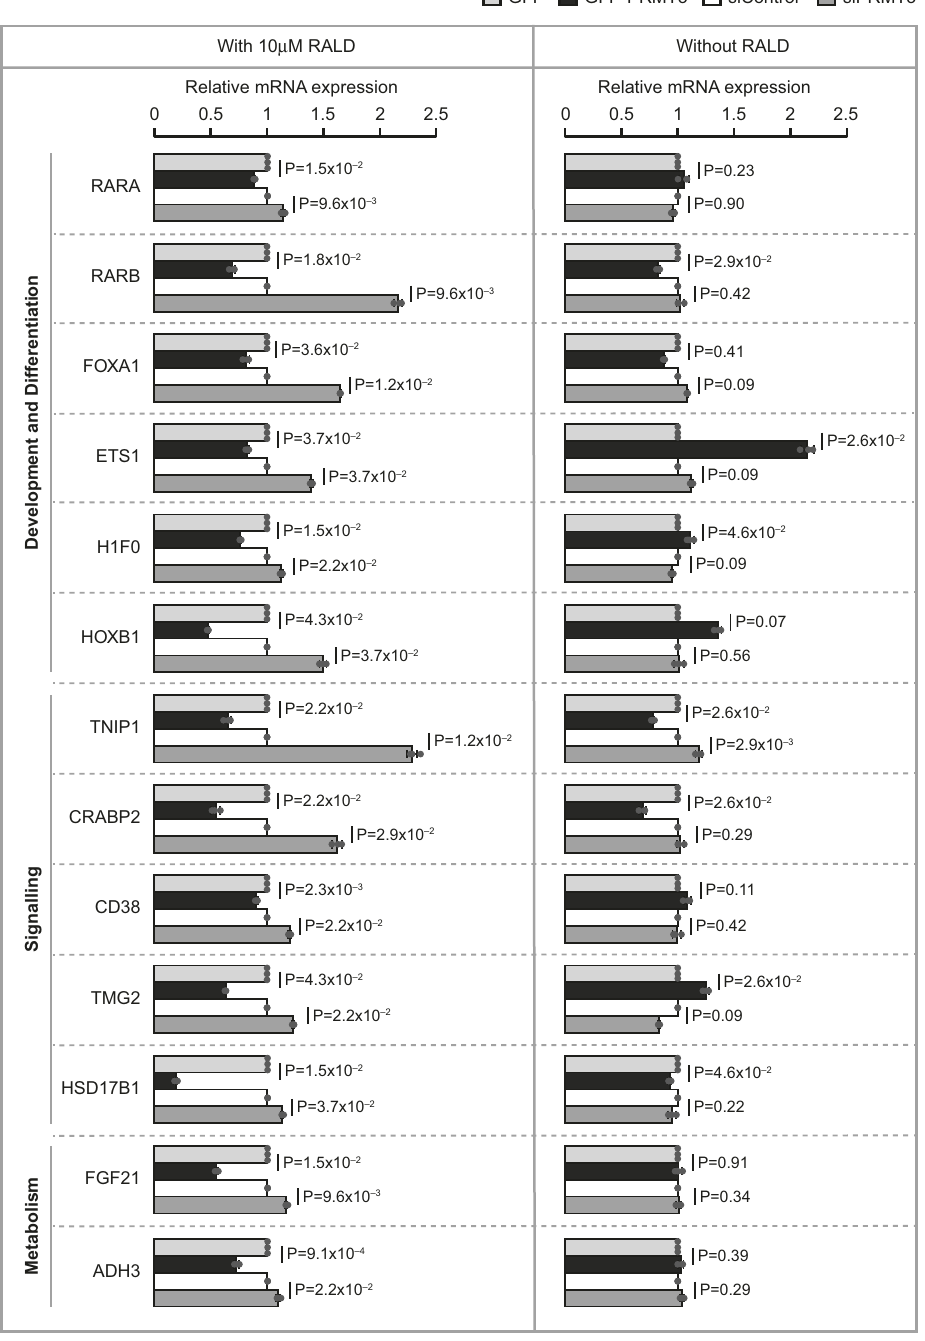
Fig. 6 PRMT3 negatively regulates the expression of RA-responsive genes. HEK293 cells were transfected with GFP vector or GFP-tagged PRMT3 construct or control siRNA or PRMT3 siRNA and treated with or without 10 µ M of all-trans-retinal (RALD). The graph in the fi gure presents the mRNA levels of the indicated RA-responsive genes as relative expression quanti fi ed by quantitative RT-PCR. The values in the graphs represent the mean of three biologically independent experiments, with error bars representing standard deviations. The statistical signi fi cance was assessed by a two-tailed t test, and the false discovery rate (FDR) values were obtained upon correcting the P values for multiple testing using Benjamini – Hochberg method (Supplementary Data AL-FL, pET28a-AL-FL, and pDsRed-AL-FL constructs. E338Q mutation in A vector (Invitrogen) using EcoRI and XhoI sites in frame with the C-terminal pEGFP-PR-FL and pCDNA4-HA-PR-FL constructs and H464A, N465A, R466A, Myc/His tag to generate the pCDNA4-myc-AL-FL construct. AL-FL, N-terminal and V468A mutations in pGEX-PR-FL were introduced by using the site-directed domain of ALDH1A1 (AL-NTR) (amino acids 1 – 335), and C-terminal domain of mutagenesis method, as previously described 58 . The full-length PRMT2 , PRMT5 , ALDH1A1 (AL-CTR) (amino acids 335 – 501) were subcloned in pGEX-6P2 vector using EcoRI and XhoI sites to generate the pGEX-AL-FL, pGEX-AL-NTR, and PRMT6 , and PRMT7 were cloned in pEGFP-C1 vector to generate pEGFP-PRMT2 pGEX-AL-CTR constructs. AL-FL was also subcloned in pEGFP-C1, pET28a or pEGFP-PRMT5 or pEGFP-PRMT6 or pEGFP-PRMT7 constructs, respectively. vector, and pDsRed-N1 monomer vectors (Clontech) using XhoI and EcoRI sites, EcoRI and XhoI sites, and KpnI and XhoI sites, respectively to generate pEGFP-